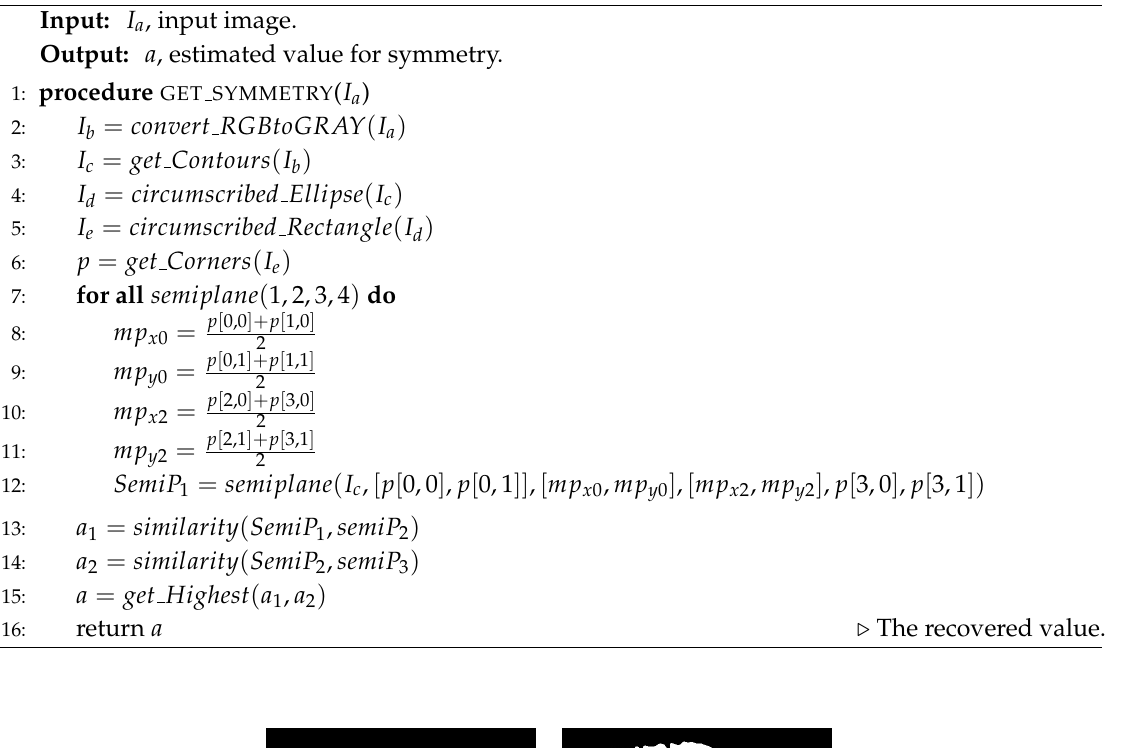
Algorithm 5 Proposed method to evaluate symmetry ( a ) , showing lines 1–14, corresponding to the images in Figure 3c.